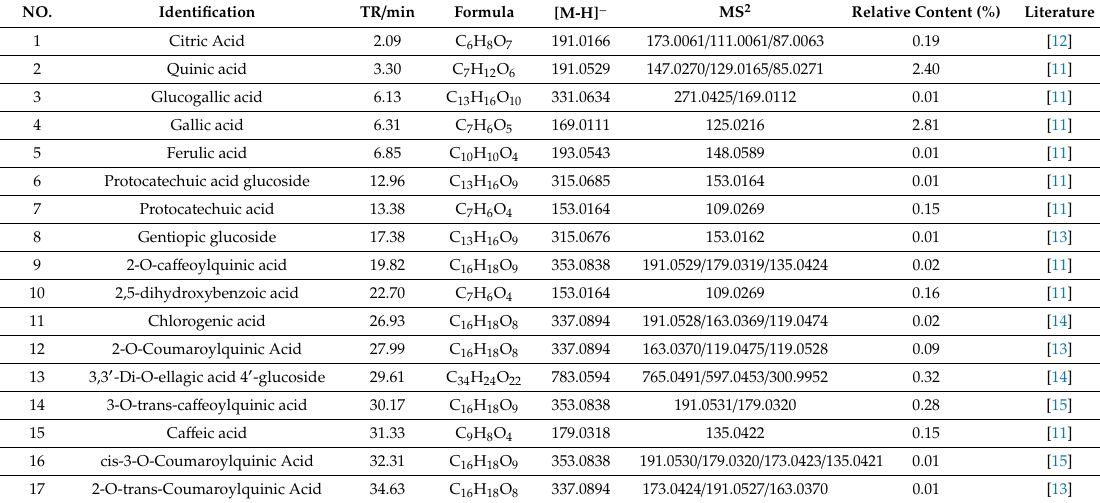
Figure 1. Total ion chromatogram of compounds in aqueous extracts from the E. globulus leaves using UPLC-Q-Orbitrap-MS. Table 1. Analysis of bioactive components of E. globulus leaves by